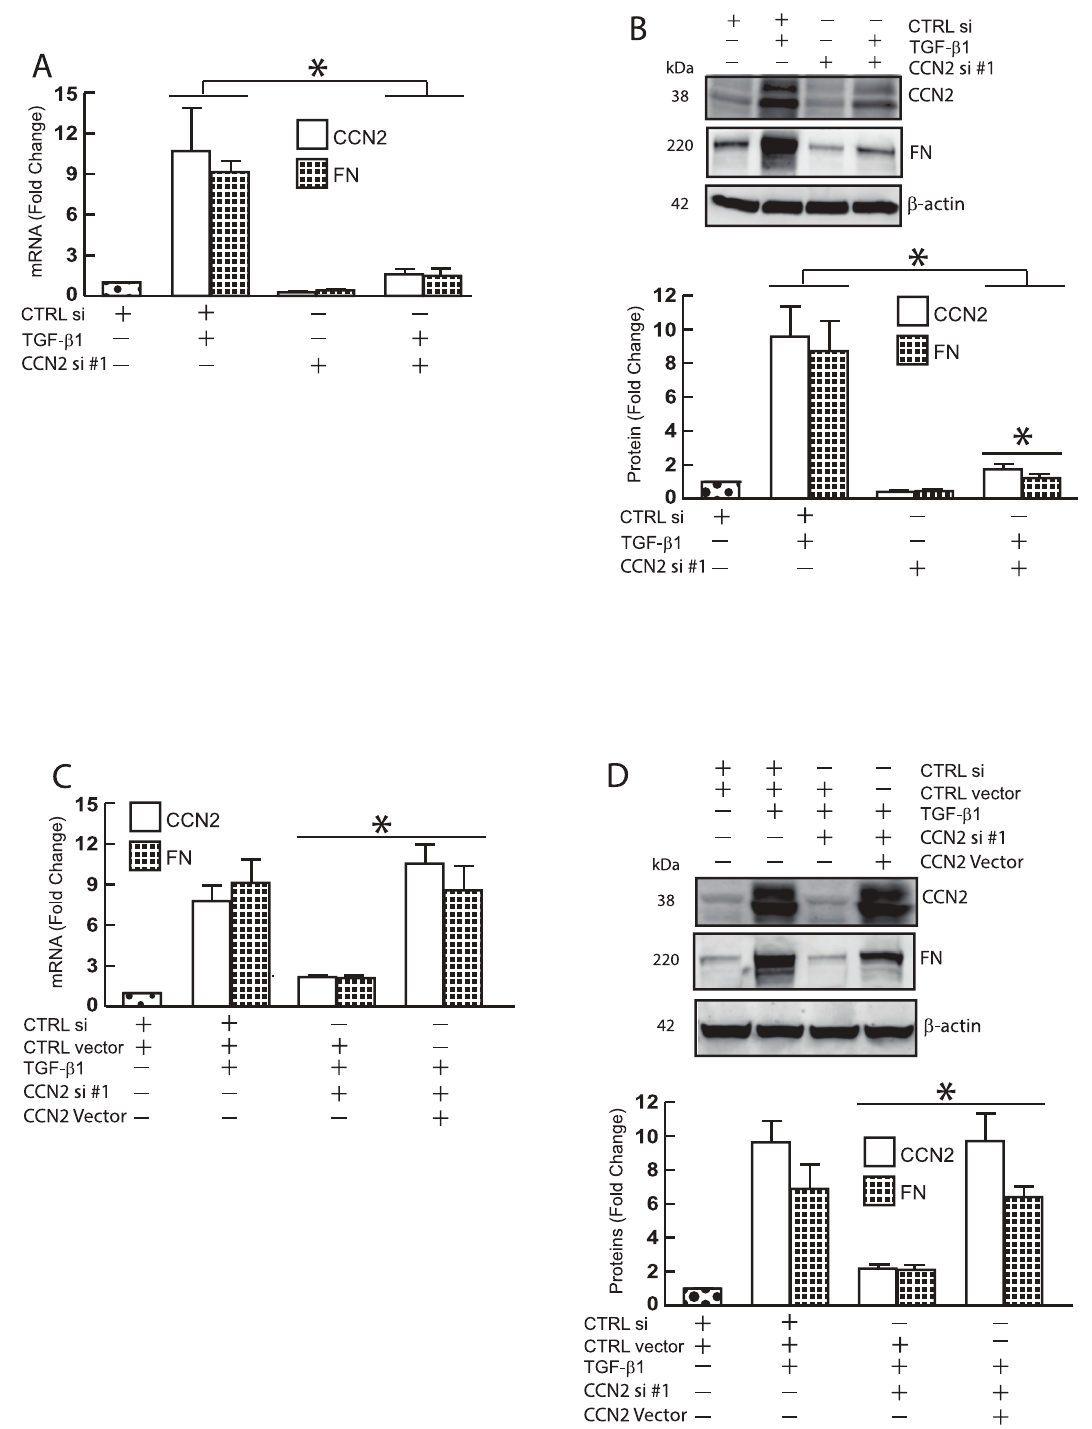
Fig 2. TGF- β -dependent FN expressionis mediated by CCN2 in primary dermal fibroblasts. Primary dermal fibroblasts (1 × 10 6 ) were transfected with the indicatedsiRNAs (20nM) and plasmidvectors (1 μ g). 32 hours after transfection, cell were treated with TGF- β 1 (5 ng/ml) for 16 hours. Total RNA and whole cell extract were prepared48 hours after transfection. mRNA and protein levels were quantifiedby real-time RT-PCR and Western analysis, respectively. mRNA levels were normalized to mRNA for 36B4, a ribosomalprotein used as an internalcontrol for quantitation.Protein levels were normalized by β -actin (loadingcontrol). Insets show representative Western blots. (A, C) CCN2 and FN mRNA. (B, D) CCN2 and FN proteins. Data are expressedas mean ± SEM,N = 3. * p < 0.05vs control.